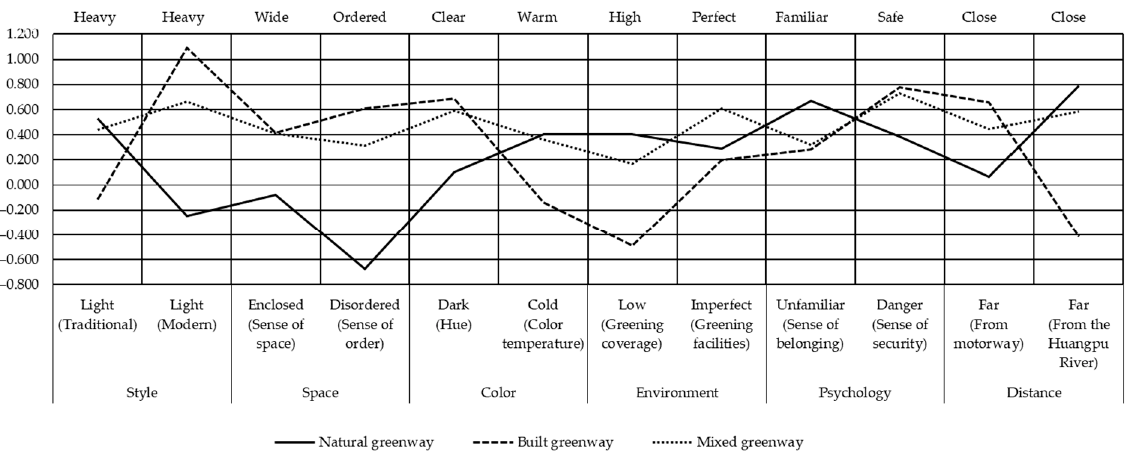
Figure 7. Semantic differential evaluation curve of different greenway types.